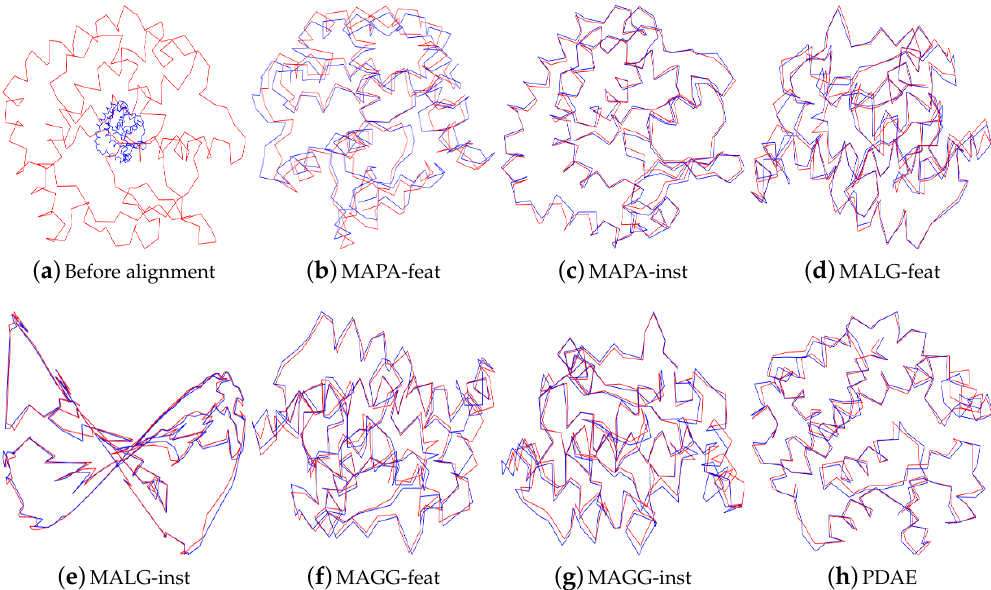
Figure 3. Protein structure manifold alignment. 3D structure of the glutaredoxin protein PDB-1G7O: The blue graph shows Model 1, and the red graph shows Model 21 scaled by a factor of four. ( a ) shows the manifolds before alignment. The other subfigures show the resulting alignments using ( b ) MAPA-feature (feat), ( c ) MAPA-instance (inst), ( d ) MALG-feat, ( e ) MALG-inst, ( f ) MAGG-feat, ( g ) MAGG-inst and ( h ) PDAE.